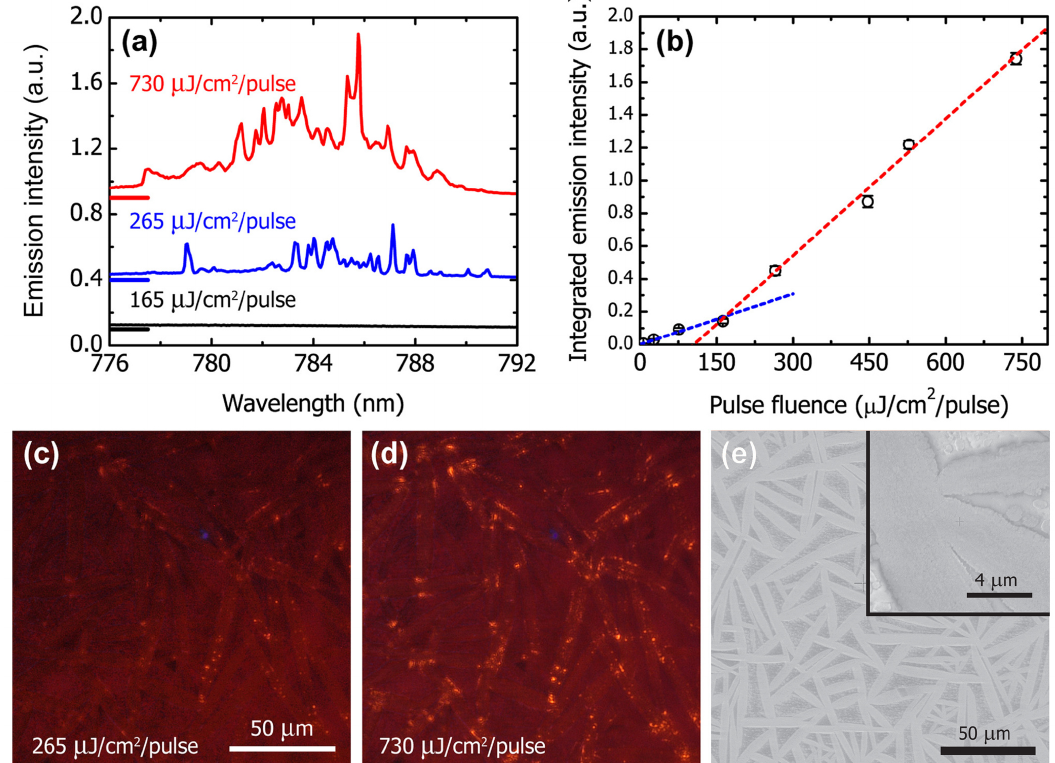
Figure 4. ( a ) Emission spectra collected below (black), near (blue), and above lasing threshold (red). The spectra were offset vertically for clarity; horizontal line-segments at the left of each spectrum indicate their corresponding zero-levels. ( b ) Integrated emission intensity as a function of excitation pulse fluence, showing evidence of the presence of a slope variation due to the random lasing threshold. ( c , d ) Micro-PL images showing the spatial distribution of emission at the two highest pump intensities in ( a ). Bright spots observed in ( d ) above threshold correspond to high scattering locations where laser light is efficiently out-coupled from the perovskite network, as also evident by the comparison with the SEM image ( e ). Adapted with the permission from [39]. AIP Publishing,